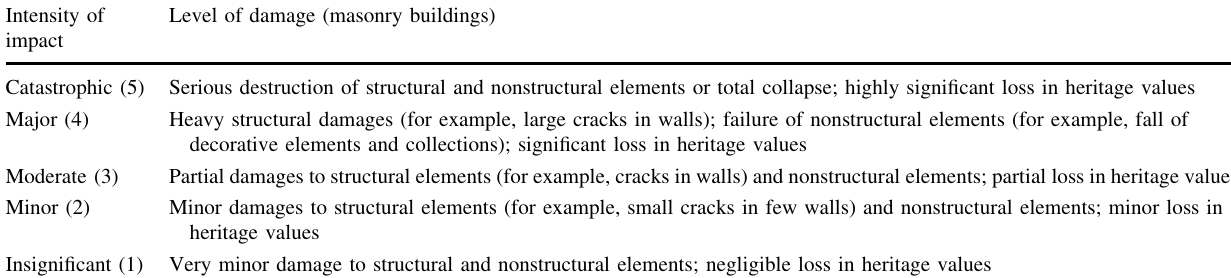
Table 3 Expected intensity of hazard impact on historic masonry buildings (a preliminary analysis) Intensity of Level of damage (masonry impact